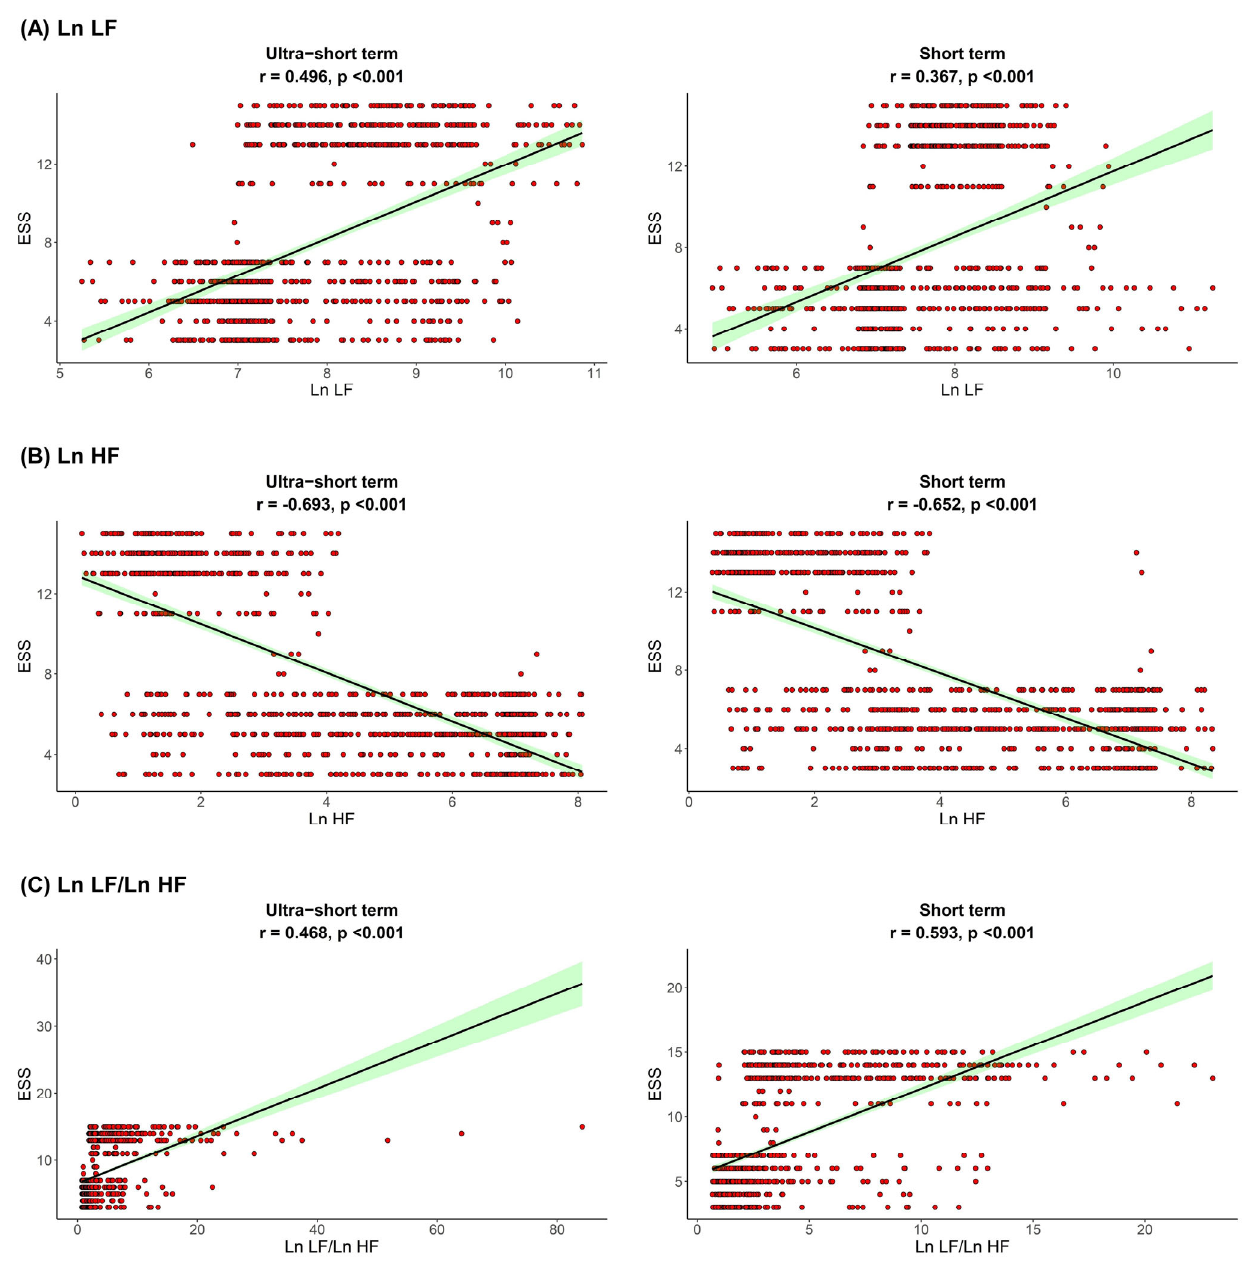
Figure 3. Correlation between ESS and ( A ) Ln LF, ( B ) Ln HF, ( C ) Ln LF/Ln H. Epworth sleepiness scale ESS, total power; Ln TP, very low frequency; Ln VLF, low frequency; Ln LF, high frequency; Ln HF, low frequency.